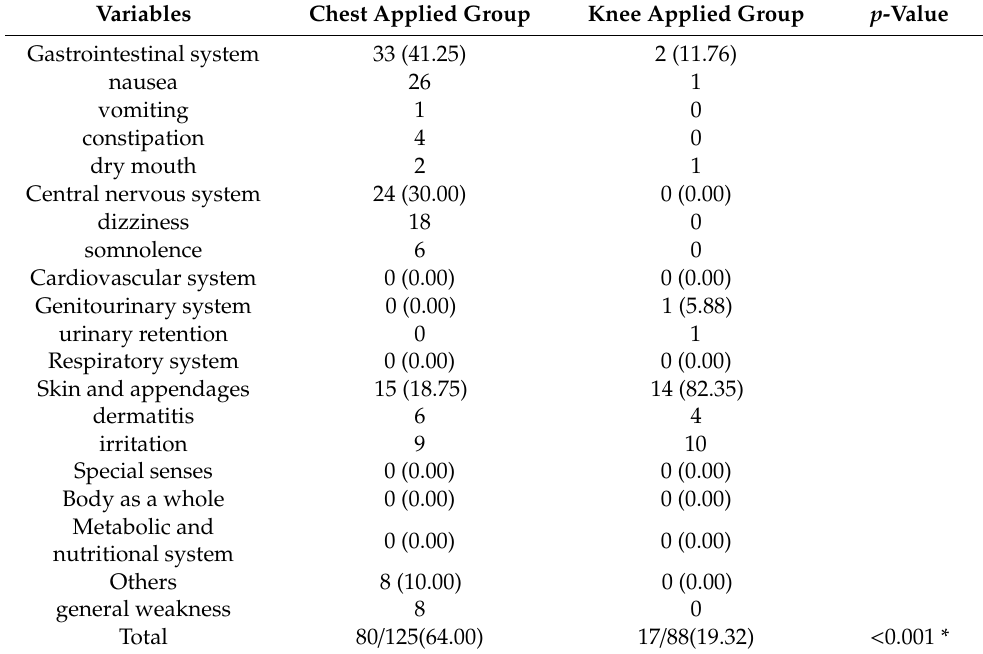
Table 4. Comparison of the adverse e ff ects between the chest applied group and knee applied